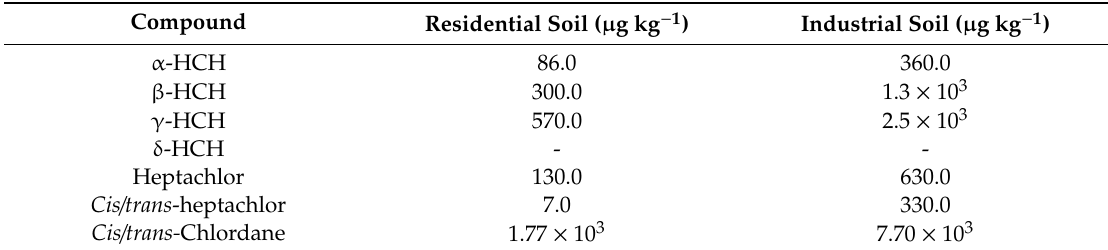
Table 1. Maximum recommended limits for the organochlorines in residential and industrial soils (adapted from the Environmental Protection Agency—EPA)